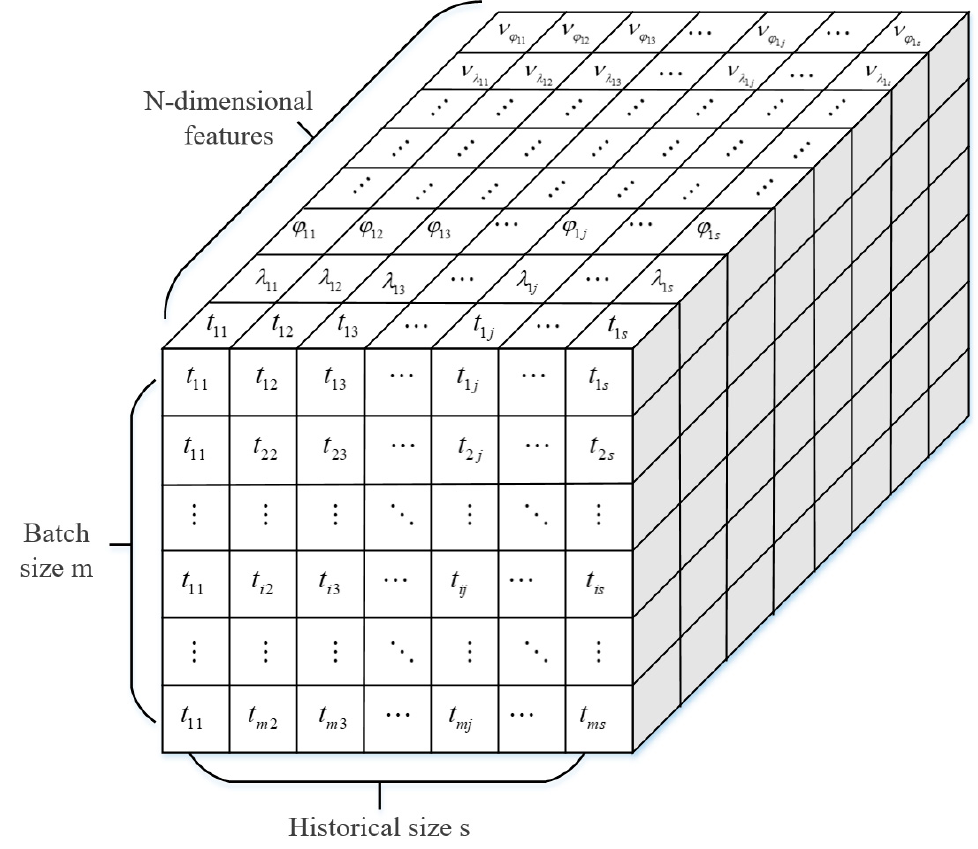
Figure 3. The input structure of the CNN prediction model.